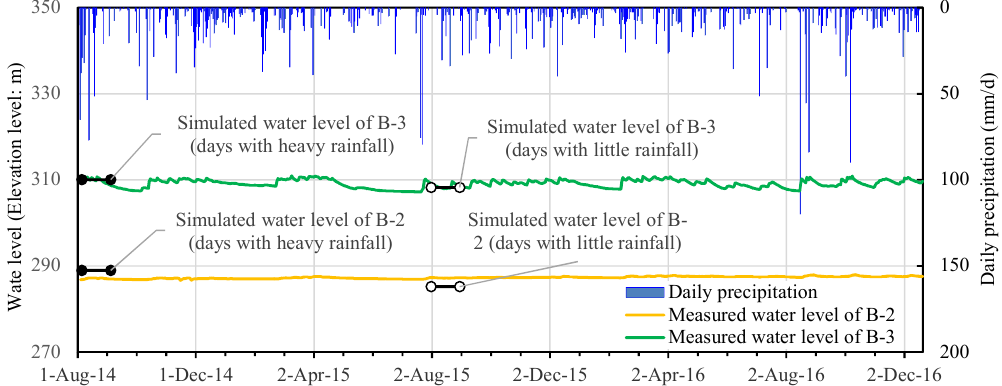
Figure 7. Change of precipitation and groundwater levels at B-2 and B-3.